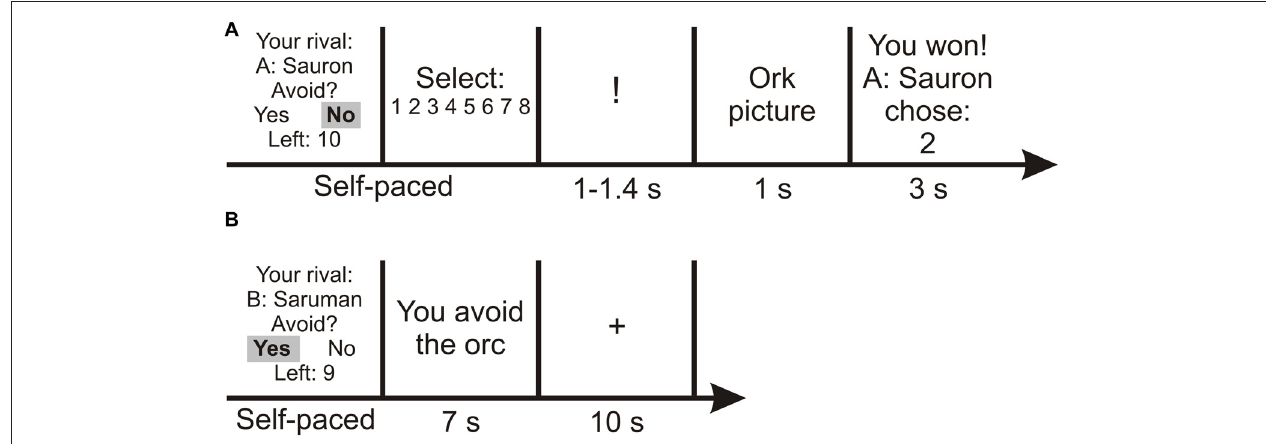
FIGURE 1 | Example trials of the Fight-or-Escape (FOE) paradigm. (A) Trial in which the participant confronted the opponent. (B) Trial in which the participant avoided the opponent. The fixation cross is only depicted for the avoidance trial, but appeared regardless of the participant’s decision. See main text for